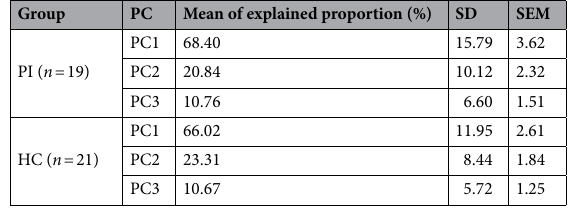
Group PC Mean of explained proportion (%) SD